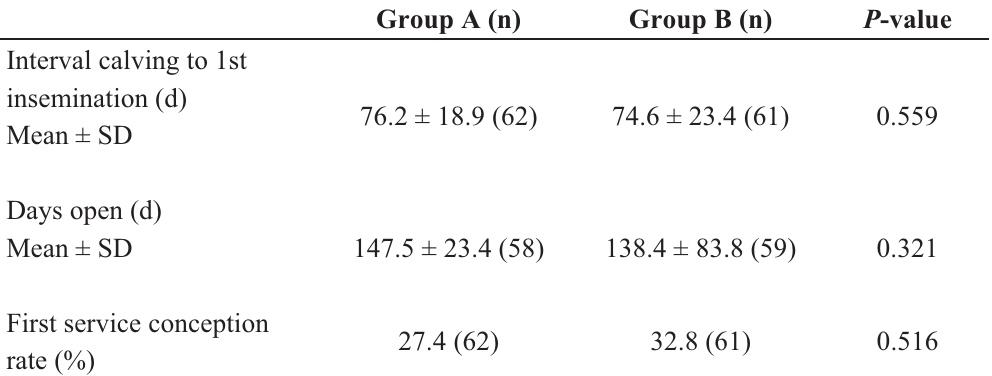
Table 4. Reproductive measures of cows in Group A and Group